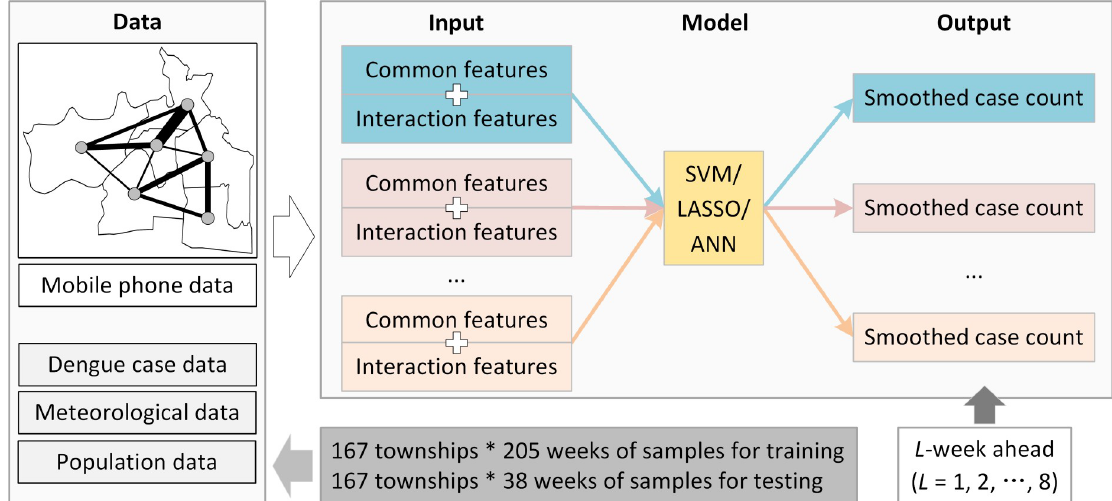
Fig 6. Framework of intra-urban dengue forecasting approach. Common features were extracted from the dengue case data, meteorological data, and population data, while the interaction features were learned from the mobile phone data. The interaction features were combined with the common features to enhance the models (i.e., SVM, LASSO, and ANN) for L -week ahead dengue